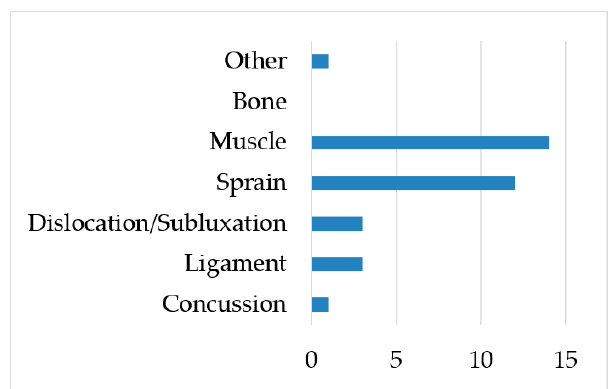
Figure 1. Injury frequency by zone ( n ).